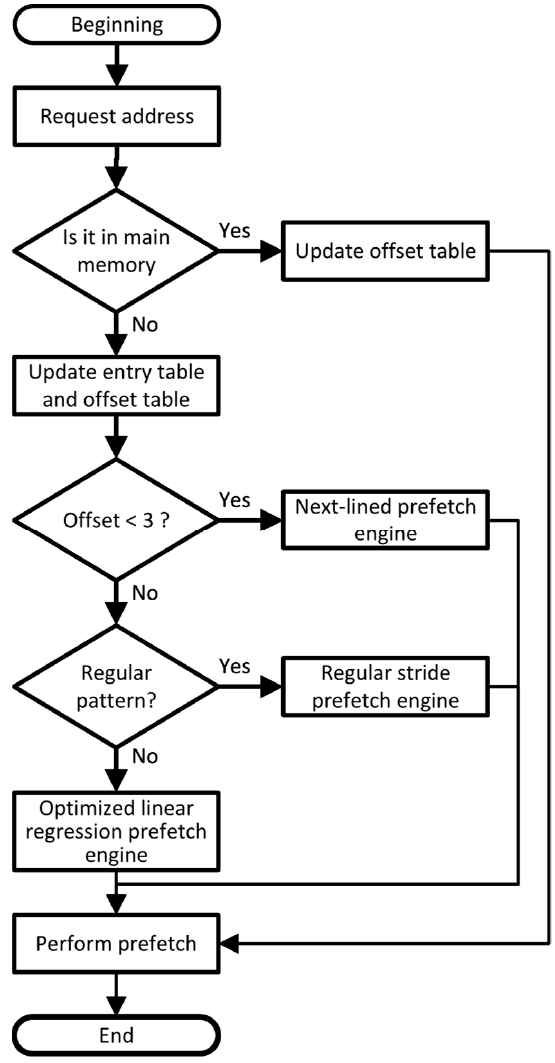
Figure 3. Operational flow of Arbitrator.